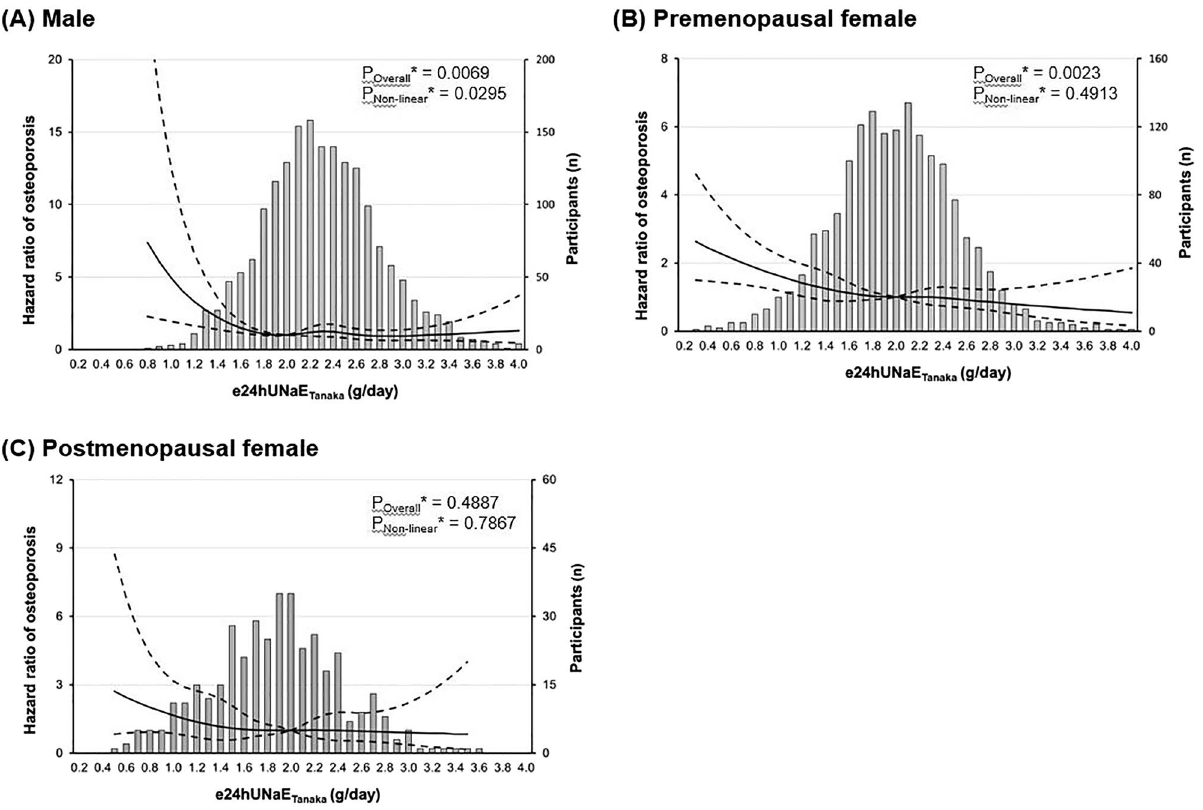
Figure 4. Sex disparity in the relationship between dietary salt intake and hazard ratio of osteoporosis. Solid line represents the adjusted HR* of osteoporosis and dash lines 95% CIs*. *Calculated by restricted cubic spline Cox-proportional hazard regression model using age, sex, and smoking history as covariates and body mass index, waist circumference, hemoglobin, corrected calcium, estimated glomerular filtration rate, triglyceride, and urine potassium/creatinine ratio as